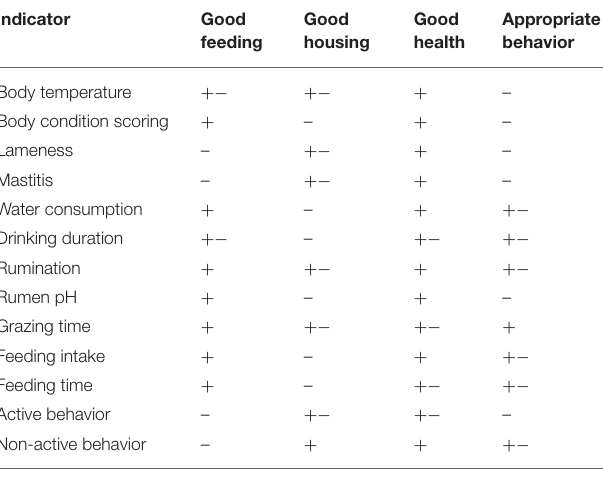
TABLE 4 | Indicator evaluation for relevance in assessing good feeding, housing, health, and appropriate behavior a .